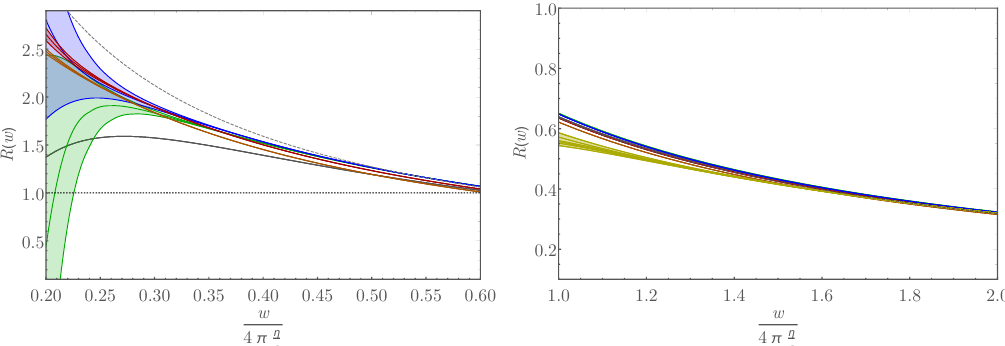
Figure 3 . Anisotropy function for di(cid:11)erent values of (cid:21) GB (left) and RTA (right) as a function of rescaled gradient ws= 4 (cid:25)(cid:17) . The grey, green, blue, red and orange curves correspond to the real parts of the inverse Borel transform of the leading order in the trans-series while the yellow curve in the left panel corresponds to RTA (for di(cid:11)erent choices of the Pad(cid:19)e order N ). The bands are determined by adding and subtracting the imaginary part of the inverse Borel transform, as a gauge of the importance of additional trans-series contributions. In both panels, the dashed line corresponds to the (cid:12)rst order hydrodynamic prediction R 1st . The grey, red and orange curves show hyd no noticable deviation for the entire range plotted above. The green and blue curves are stable with respect to the choice of N for w > 0 : 25, with deviations remaining within the same order 4 (cid:25) (cid:17) s of magnitude as the curves plotted above. The sensitivity of the RTA bands to di(cid:11)erent choices of N is no greater than 6% for w > 4 (cid:25) (cid:17) s